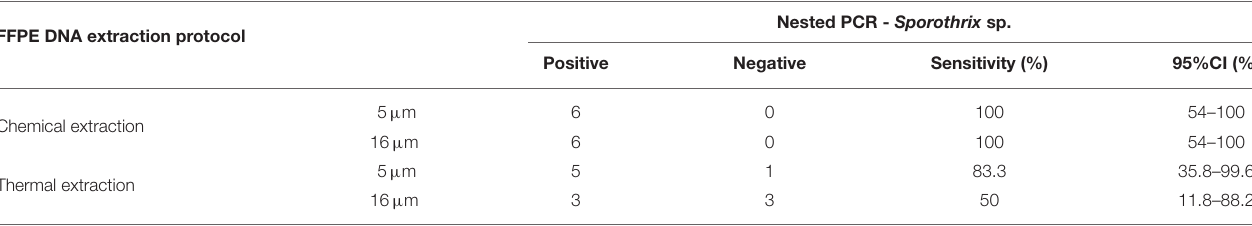
TABLE 1C | Comparison of chemical and thermal DNA extraction protocols in six FFPE pellet samples of Sporothrix sp. and negative controls, using the two paraffin sectioning protocols (5 µ m and 16 µ m), in relation to positivity, method sensitivity and confidence interval (95% CI). FFPE DNA extraction protocol